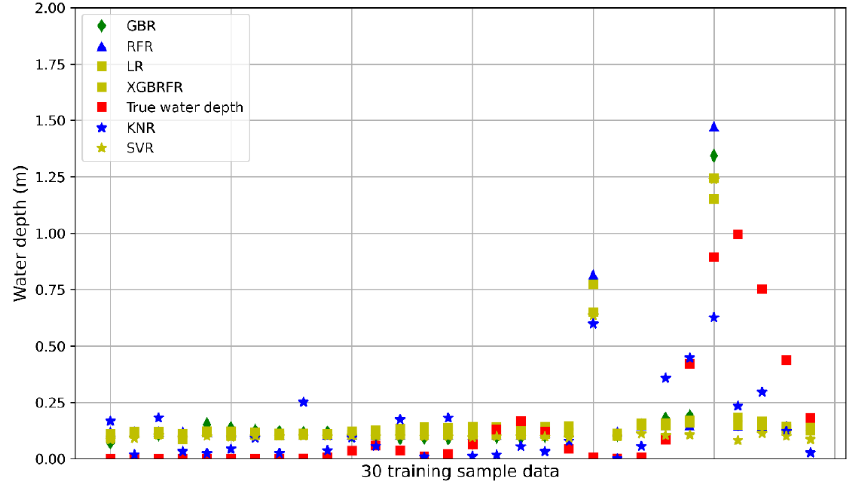
Figure 13. Input feature importance.